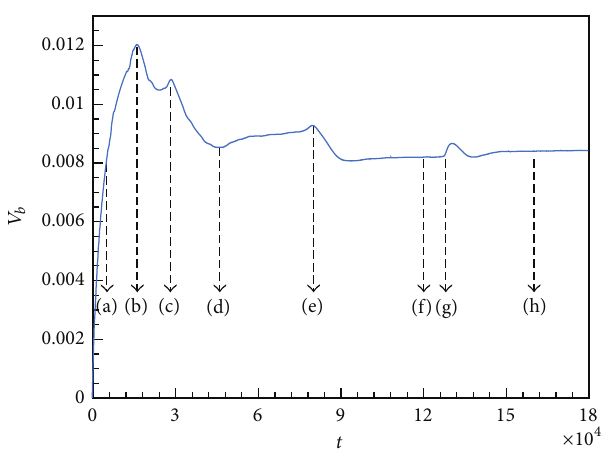
Figure 6: Time evolution of the rising velocity of four bubbles for Eo = 2 .